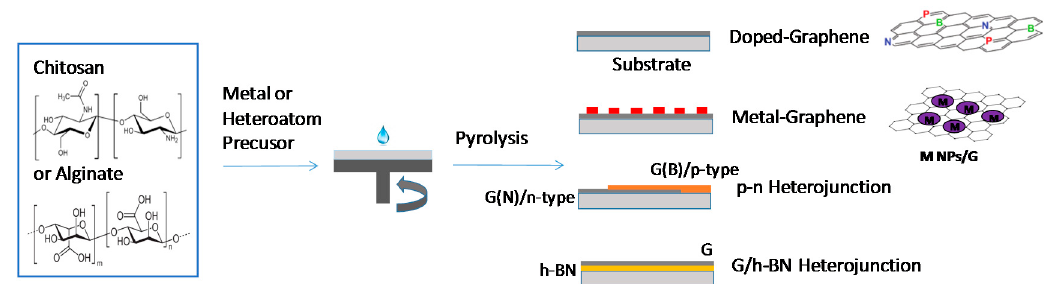
Scheme 1. Pictorial illustration of the one-step preparation of doped graphene and various types of graphene heterojunctions.